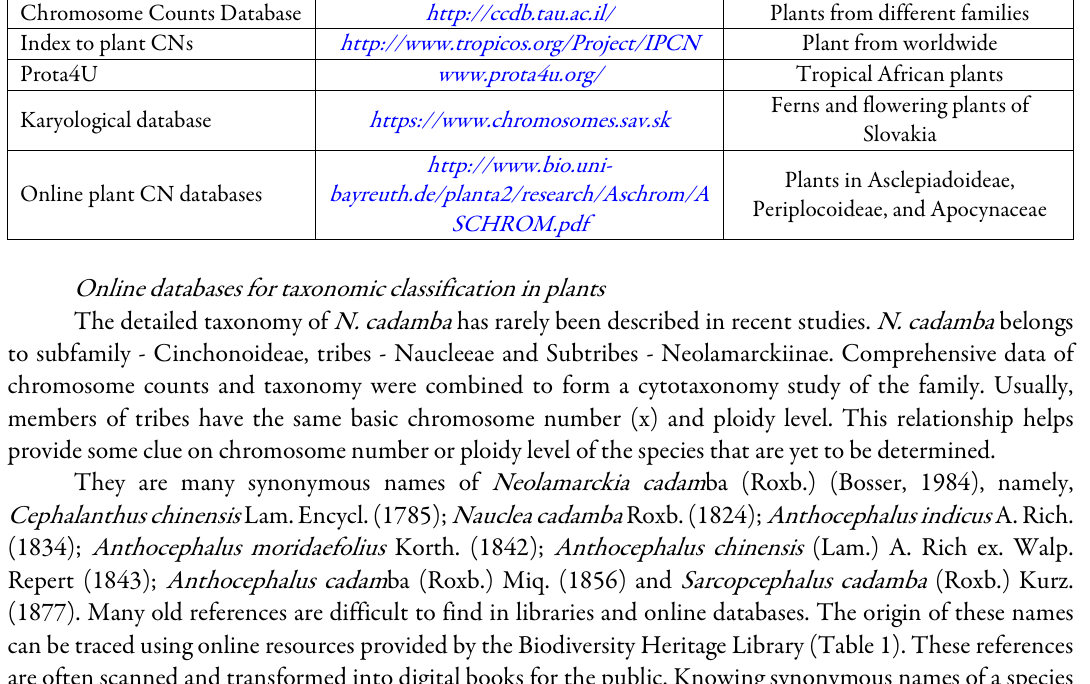
Table 2. Online databases for chromosome numbers in plants